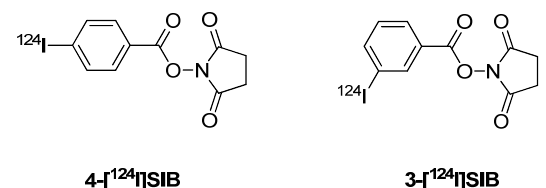
Figure 2. Structures of 4-[ 124 I]SIB and 3-[ 124